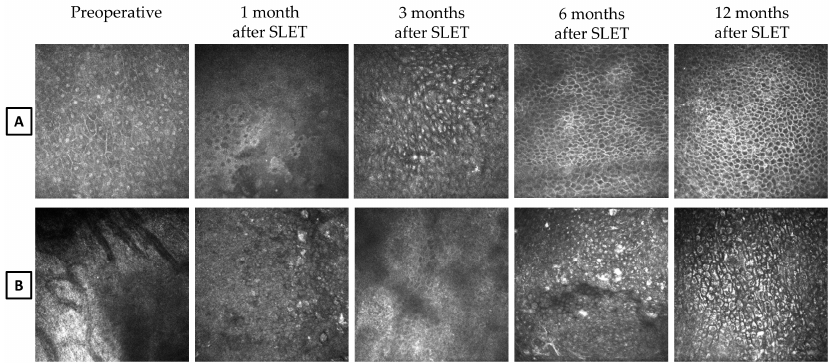
Figure 4. Basal epithelium in the central cornea in a successful ( A ) and in a partial successful ( B ) patient, preoperatively and at 1, 3, 6, and 12 months after Simple Limbal Epithelial Transplantation (SLET). Preoperative, in ( A ) is clearly distinguishable a conjunctivalized epithelium and in ( B ) the presence of neovascularization. After SLET, in the successful case ( A ) we could distinguish at 1-month, remnants of the amniotic membrane epithelium with well-defined bright thick borders and homogeneous cytoplasm lacking nuclear details;at 3 months, immature epithelium with small indistinct cell borders, bright nuclei, and a high nucleus-to-cytoplasm ratio; at 6- and 12-months, a normal basal corneal epithelium; neither goblet cells nor cystic formations were detectable in all corneal sectors. After SLET, in the partial successful case ( B ) we could distinguishat 1- and 3-months, epithelial cells scarcely identifiable with small cell body, poorly defined bright borders, dark cytoplasm, and no visible nuclei; at 6-months, the detectable epithelial cells were enlarged, hyper-reflective, and had activated nuclei with a decreased nucleus-to-cytoplasm ratio;at 12-months, the corneal surface was intact, and cells maintained a dysmorphic pattern (representative results from patient no. 1, ( A ), and patient no. 3, ( B ); images are 400 × 400 µ m, the bar is 100 µ